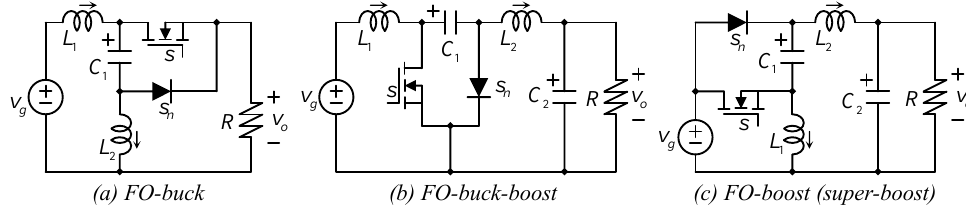
Figure 3. Fourth order version of the basic family of converters: ( a ) FO-buck, ( b ) FO-buck-boost, and ( c ) FO-boost (super-boost) converters.